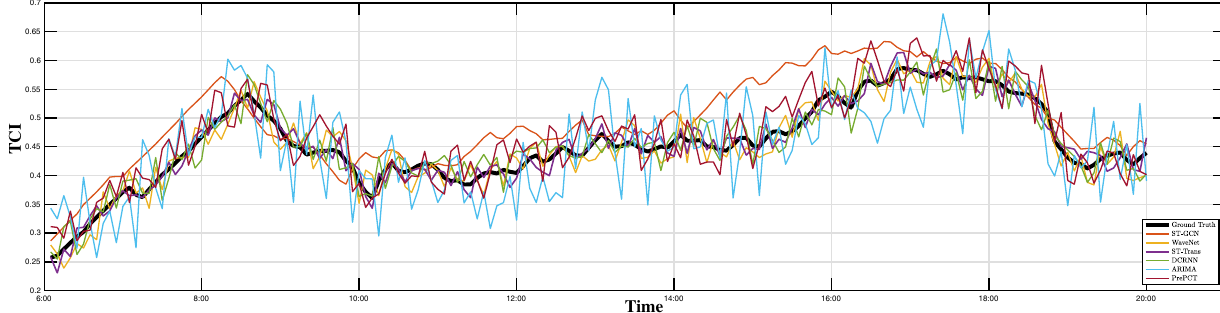
Fig. 7 TCI prediction